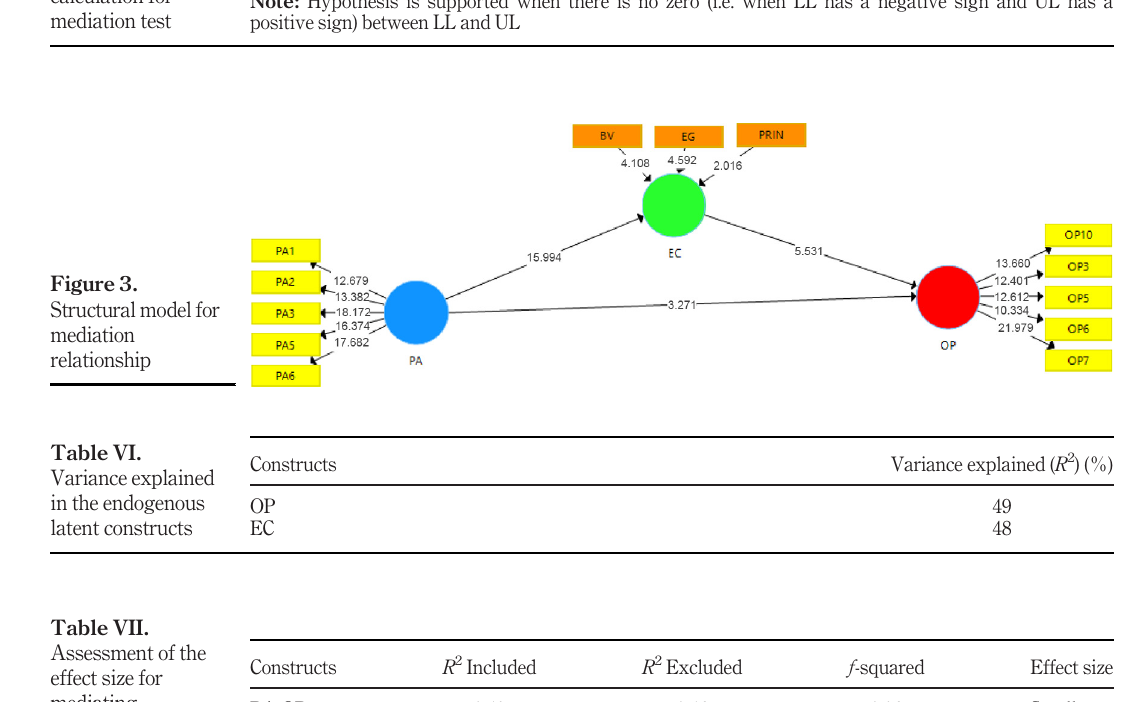
Table V. Con fi dence interval calculation